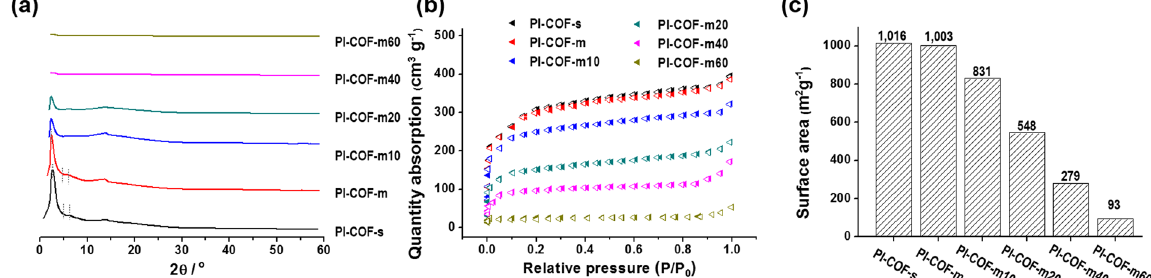
Figure 3. Crystallinity and surface areas of the PI-COF-m X series ( a ) a comparison of the synchrotron X-ray scattering profiles of the PI - COF - m X series; ( b ) nitrogen sorption isotherms of the PI - COF - m X series recorded at 77 K; and ( c ) BET surface areas obtained from the nitrogen sorption